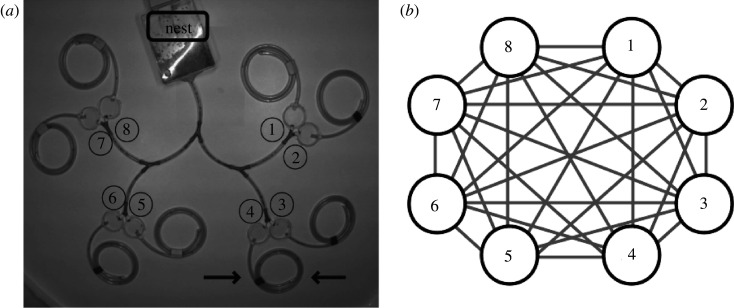
(a) Experimental set-up, labelling from 1 to 8 the nodes representing the endings of the tree structure. The black arrows indicate the plastic spirals where the food is laid. (b) Equivalent network representation of the experimental set-up, assuming every node can interact with any other.